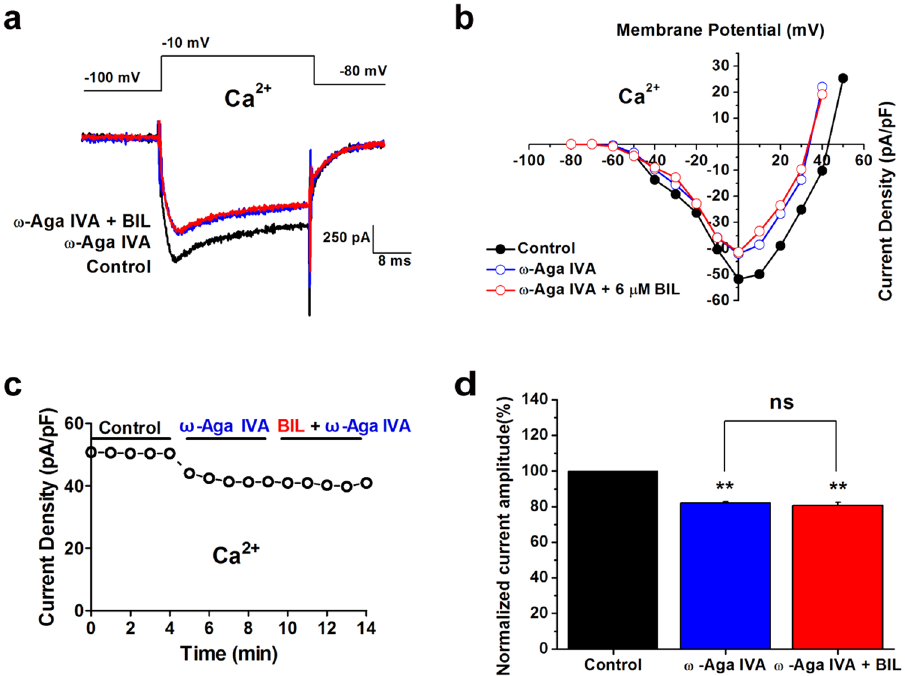
Figure 5. The bilirubin-induced enhancement of VGCC current was primarily mediated by P/Q-type channels using Ca 2 + as the charge carrier. ( a ) Representative traces in control condition (black trace) and bath application of (blue trace), followed by combined application of 500 nM ω - Agatoxin IVA and 6 μ M bilirubin (red trace). Each current was elicited by a 20 ms test pulse to − 10 mV from − 100 mV. Note a faster rate of inactivation while Ca 2 + was used as the charge carrier. ( b ) Current-voltage relationships from data in A measured at the peak current density showed HVA calcium currents in control solution (black trace), 500 nM ω - Agatoxin IVA solutions (blue trace), and 500 nM ω - Agatoxin IVA with bilirubin solutions (red trace). The inward currents peaked at about 0 mV. Charge carrier was 2 mM Ca 2 + . Note that switching the type of permeate ions also resulted a shift in the reversal potential to more positive voltages with Ca 2 + compared with Ba 2 + as the charge carrier (E rev Ca 2 + > E rev Ba 2 + ). ( c ) Time course of the effect of P/Q-type calcium channel on bilirubin-induced hyperexcitation. Calcium current density measured from recordings in the same neuron from data A and B is plotted against time before, during application of 500 nM ω - Agatoxin IVA, and combined application of 500 nM ω - Agatoxin IVA and 6 μ M bilirubin. Data were collected using 2 mM Ca 2 + as charge carrier. ( d ) The normalized VGCC current amplitude before (black bar), during application of 500 nM ω - Agatoxin IVA (blue bar), and combined application of 500 nM ω - Agatoxin IVA and 6 μ M bilirubin (red bar) from six neurons. Charge carrier, 2 mM Ca 2 + . ** p < 0.01 , ns, not significant, one-way ANOVA with Bonferroni post hoc